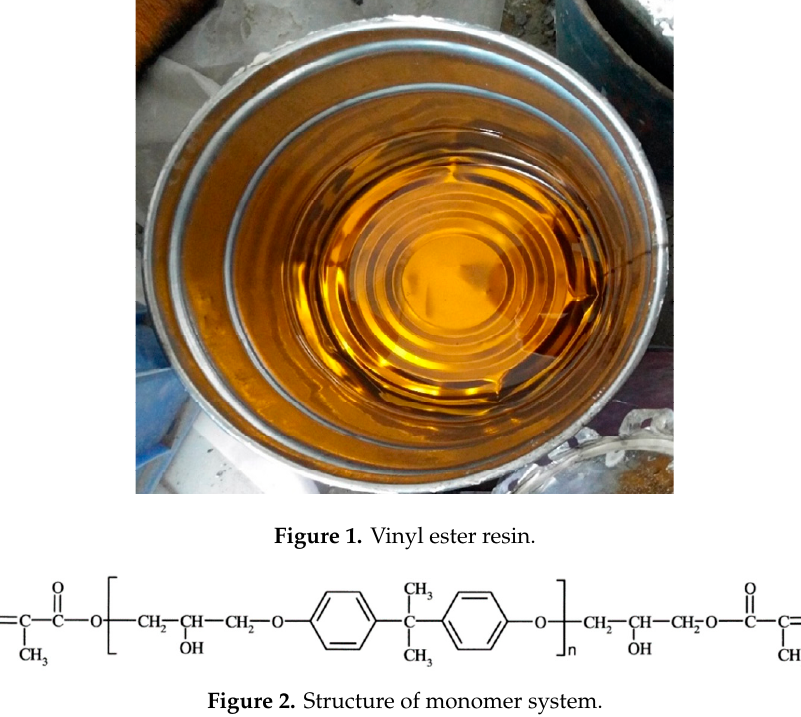
Figure 2. Structure of monomer system.